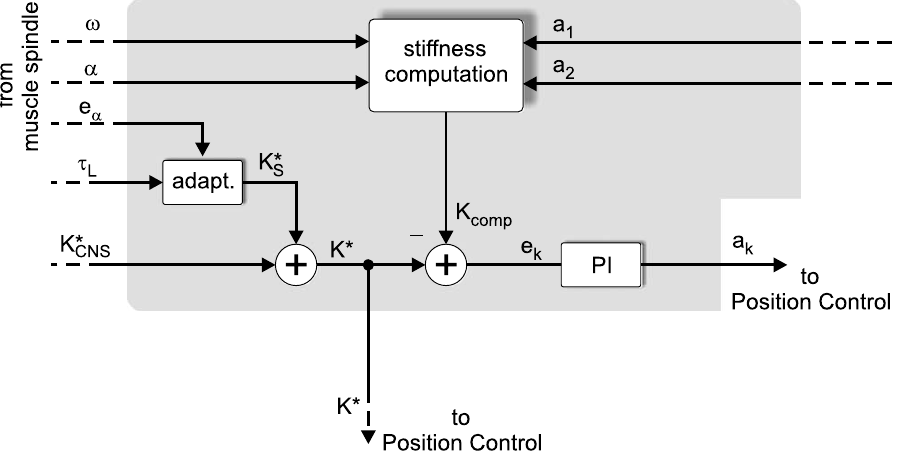
Fig. 6. Schematic of the stiffness controller. The block stiffness computation computes the actual stiffness based on the joint angle ( α ), velocity ( ω ) and activations ( a 1 and a 2 ). The desired stiffness is the sum of two parts: K ∗ tional stiffness reference generated by an adaptive block, adapt. ). The stiffness controller is a PI and its output ( a k ) acts on both muscles